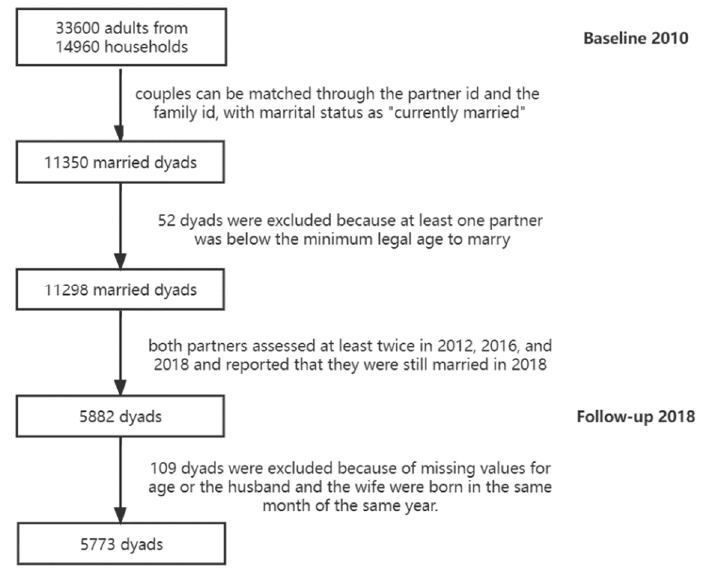
Figure 2. The flowchart of sample selection process.